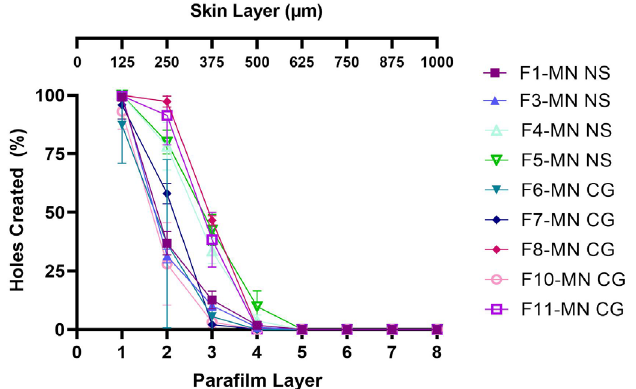
Figure 10. Illustration of the percentage of holes created in Parafilm ® M after DMN containing nano- suspension and co-grinded ketoprofen insertion (n = 3, mean ± SD, p > 0.05). nanosuspension and Co-grinded ketoprofen insertion (n = 3, mean ± SD, p >